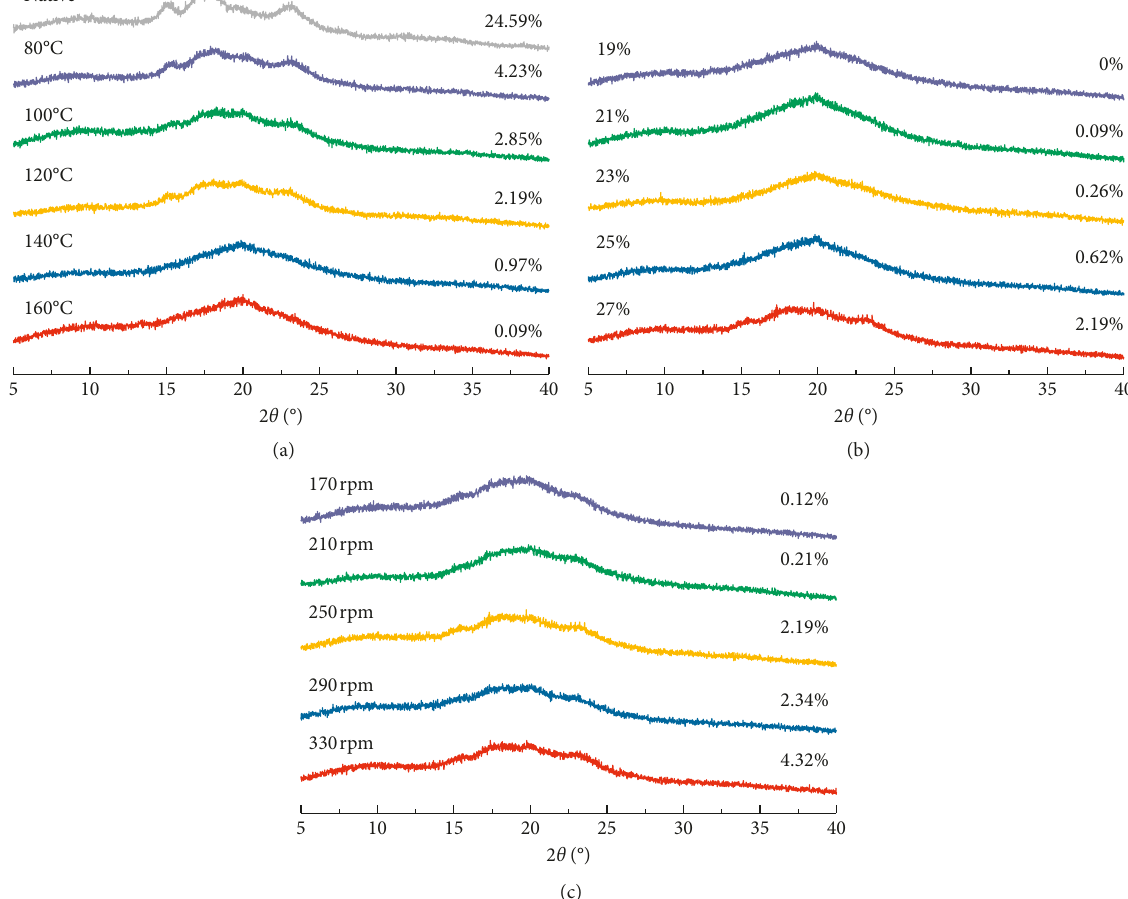
Figure 5: XRD spectra of adlay flours treated by extrusion at different extrusion conditions. (a) Barrel temperature, (b) moisture content, and (c) screw